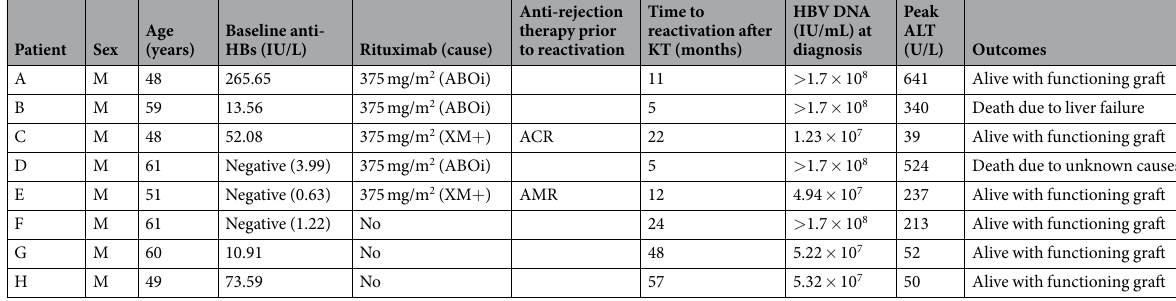
Clinical outcomes. The clinical features of the eight patients with HBV reactivation are listed in Table 2. Five